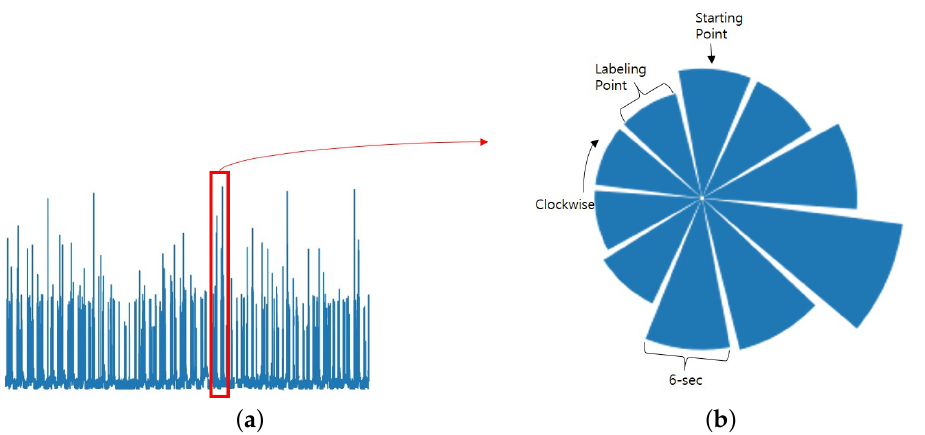
Figure 3. Power signal ( a ) transformed into a temporal bar graph ( b ).